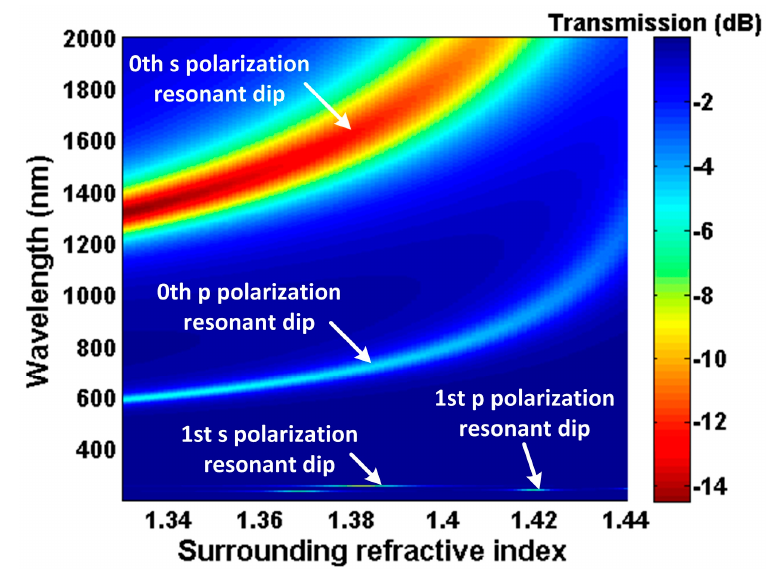
Figure 3. Transmission spectra as a function of surrounding refractive index (SRI) with d = 40 nm.